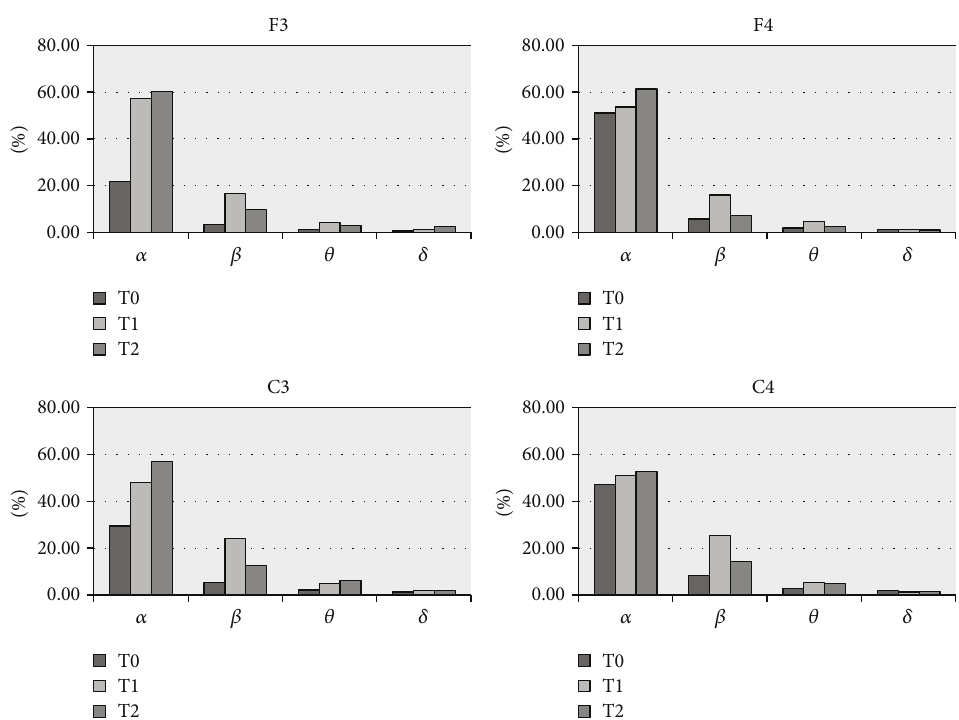
Figure 2: Delta, theta, alpha, and beta relative powers (%) prereal and postreal rTMS at T0 (beginning of the exam), T1 (after rTMS), and T2 (1 week after rTMS) in patient number 4. Almost all powers at F3, F4, C3, and C4 electrode sites increased after real rTMS treatment, especially at F3 and